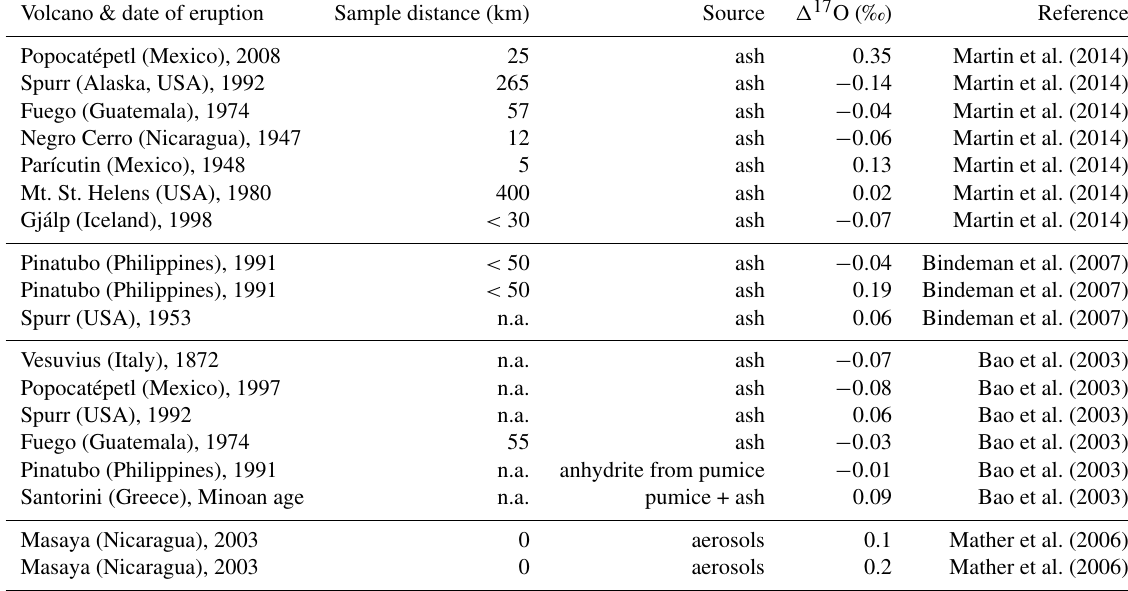
Table 1. Oxygen isotopic composition of volcanic sulfates from different tropospheric emissions of the present geological era. Volcano & date of